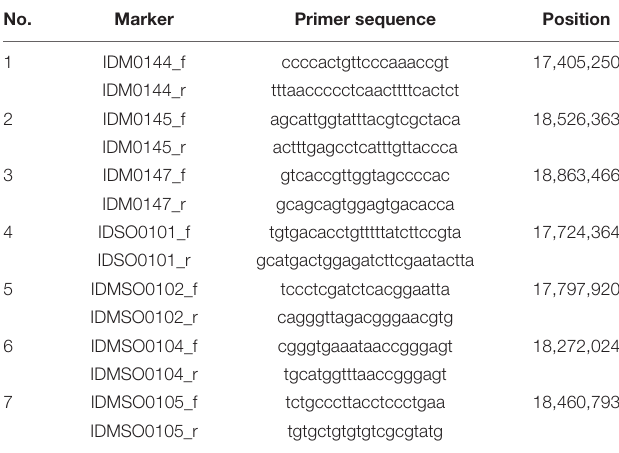
TABLE 1 | List of InDel markers for fine mapping of hwj1 locus.